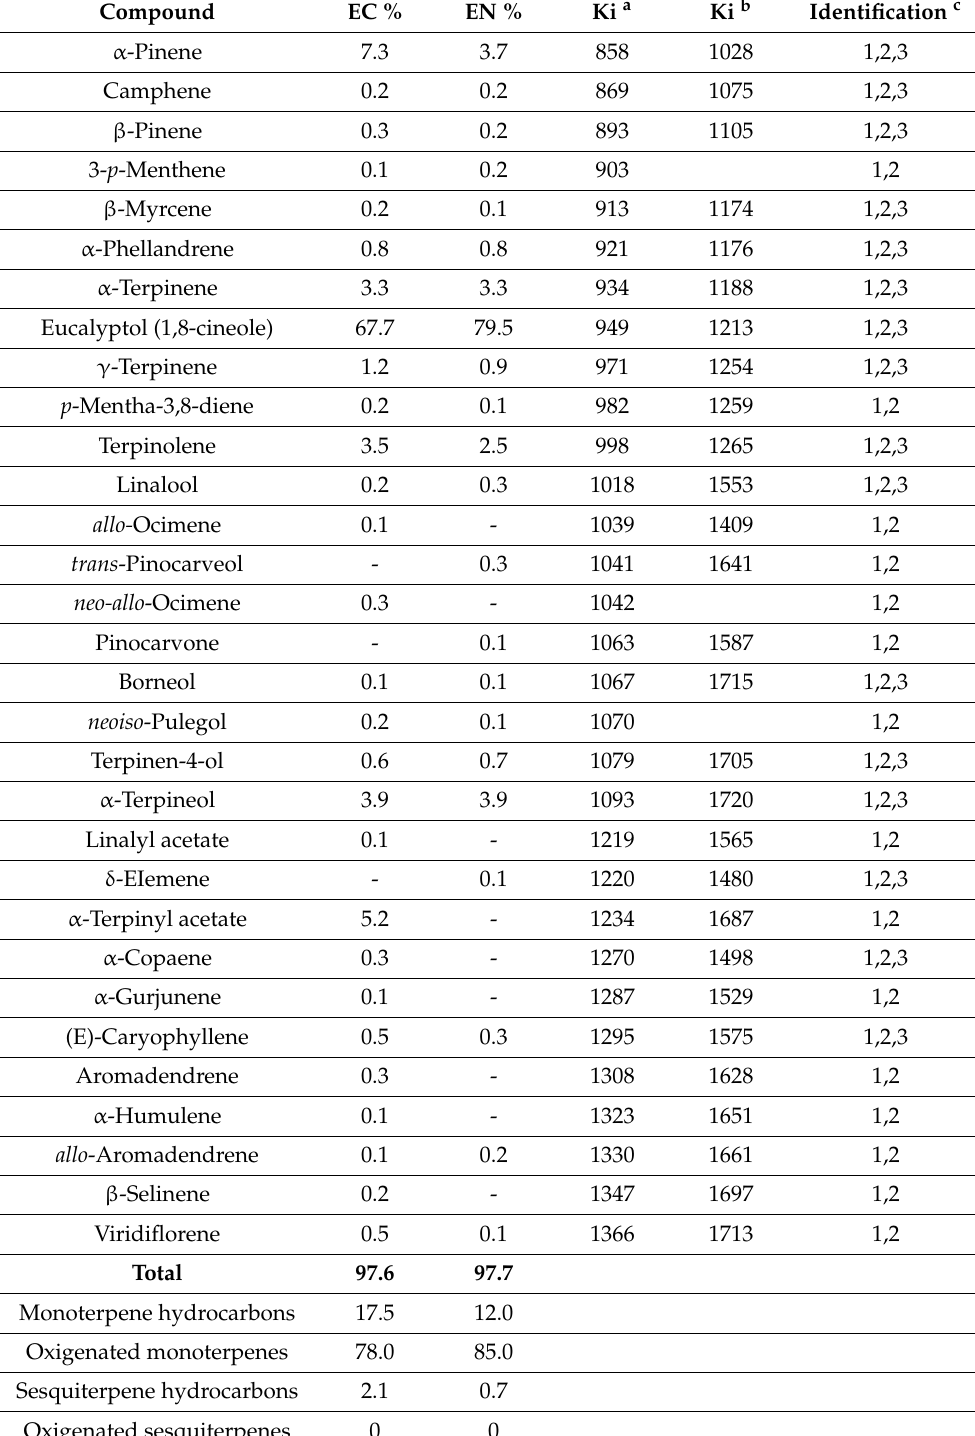
Table 2. Percent composition of the essential oils extracted from the leaves of E. cinerea (EC) and E. nicholii (EN) by-products as determined via gas chromatography–mass spectra